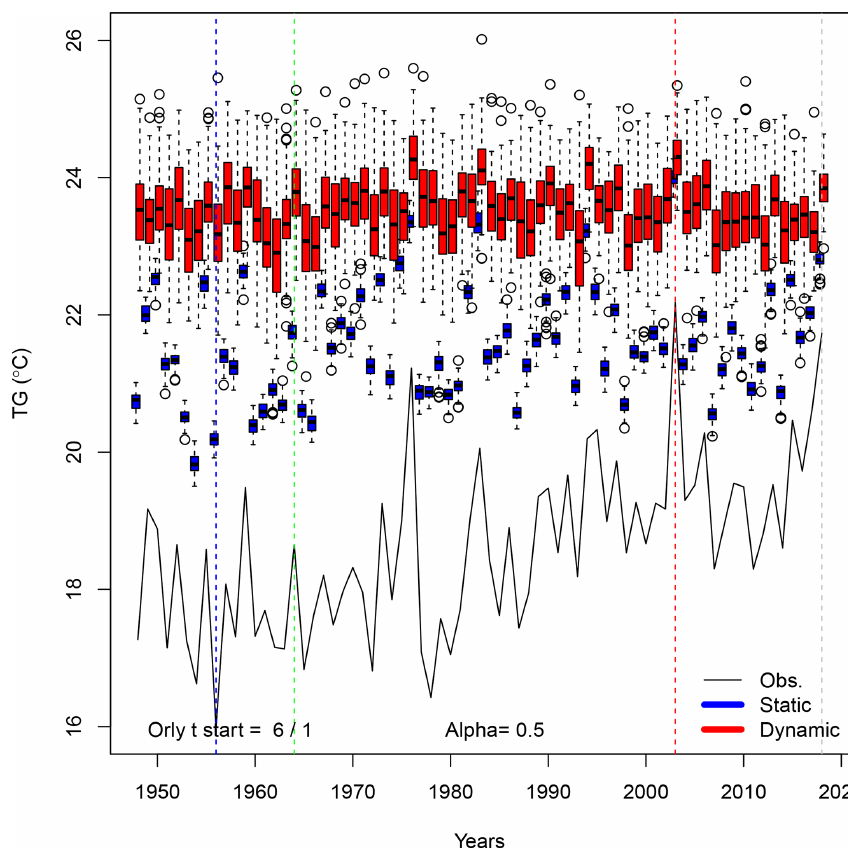
Figure B1. Time variations of probability distributions of simulated average temperatures (TG) for α TG = 0 . 5 in Orly. The black continuous line represents the observed variations in Orly summer averages between 1948 and 2018. Temperatures are expressed in degrees Celsius. The vertical colored lines outline the coldest (blue), median (green), warmest (red) and 2018 summers. The box plots represent the ensemble variability of the simulations for each year. The red box plots are for the dynamic simulations. The blue box plots are for the static simulations. The boxes of box plots indicate the median ( q 50 ), lower ( q 25 ) and upper ( q 75 ) quartiles. The upper whiskers indicate min [ max (T ), 1 . 5 × (q 75 − q 25 ) ] . The lower whisker has a symmetric formulation. The points are the simulated values that are above or below the defined